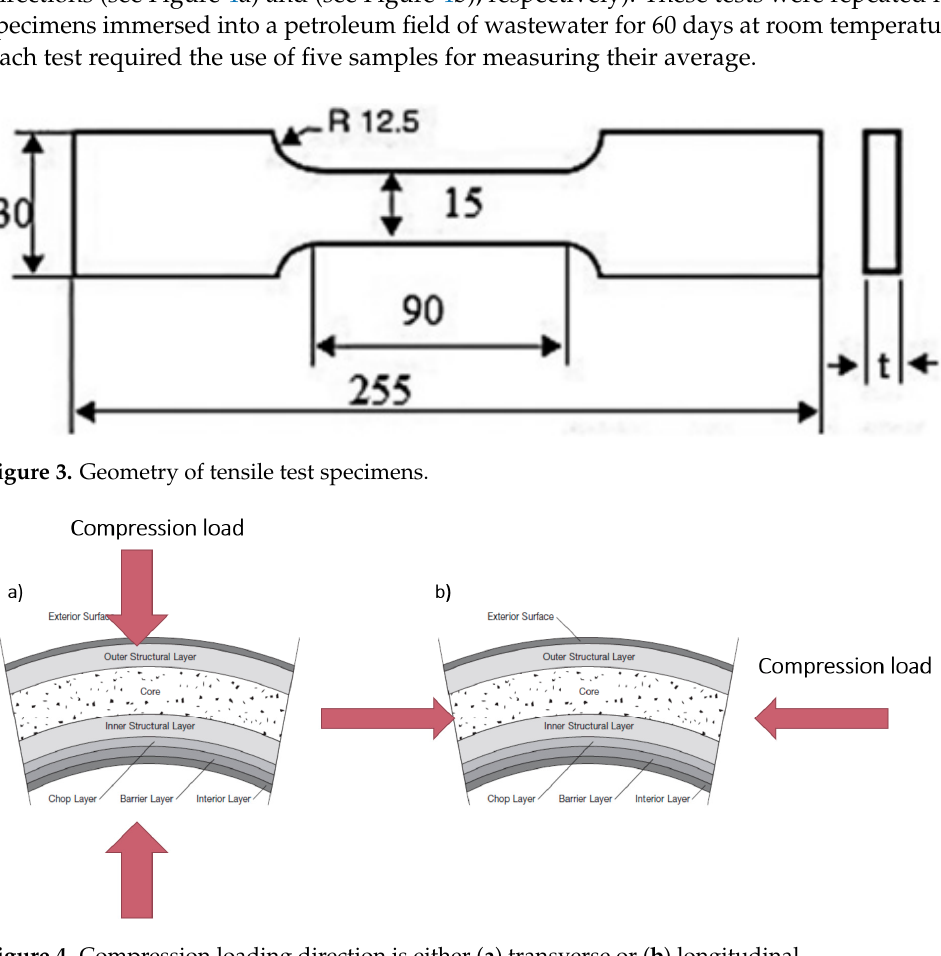
Figure 2. Chemical treatment to preconditioning the GRP pipes material.